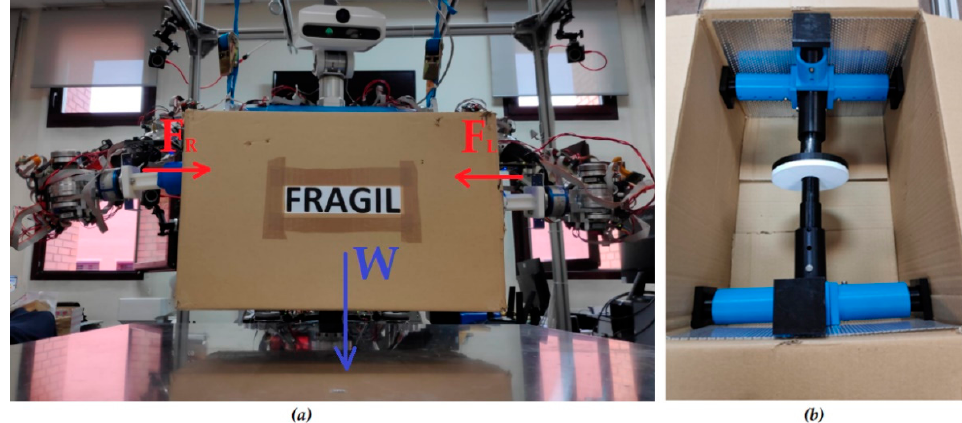
Figure 9. ( a ) Humanoid robot, TEO, lifting the box. ( b ) Internal structure of the semi-rigid box.